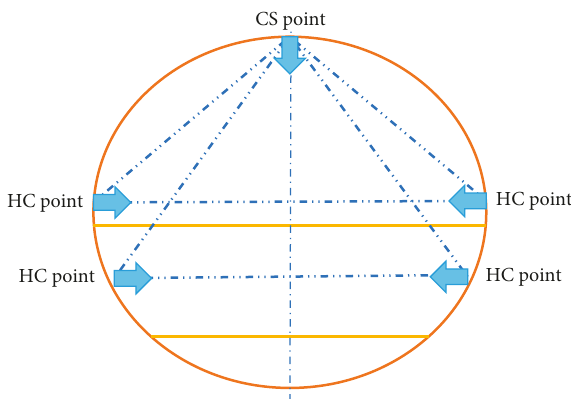
Figure 3: Tunnel deformation monitoring by